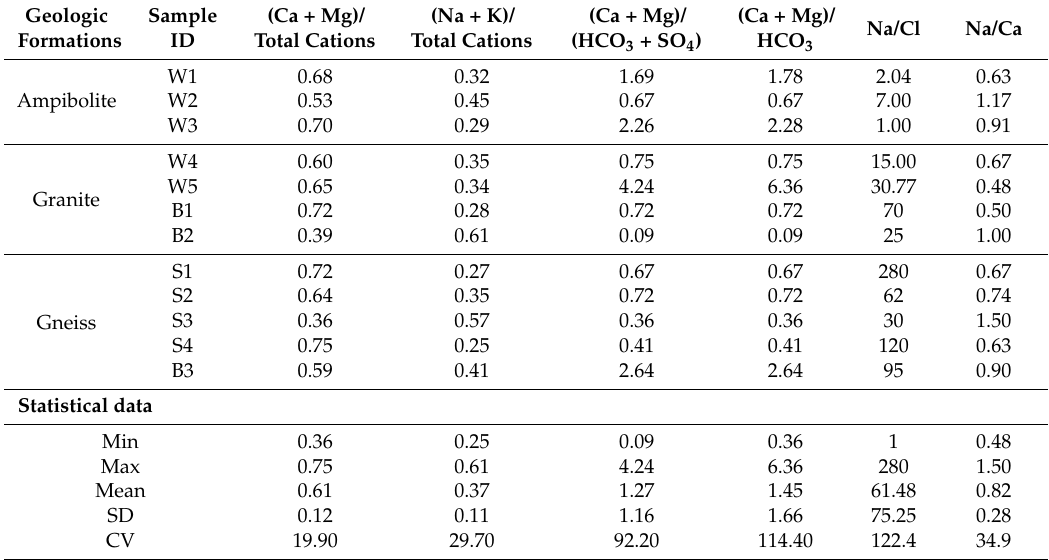
Table 6. Stoichiometric relations between some solutes in the water samples. Geologic